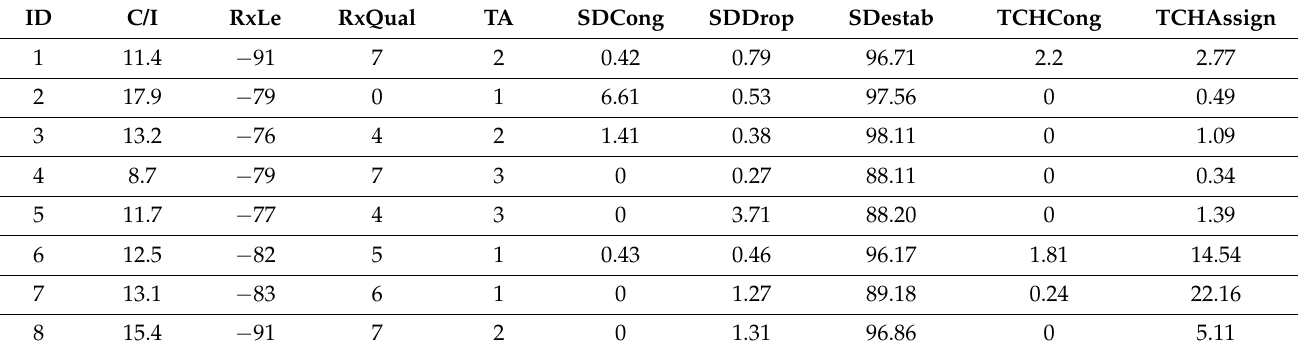
Table 10. Comparison of drive test information and performance support system for blocked